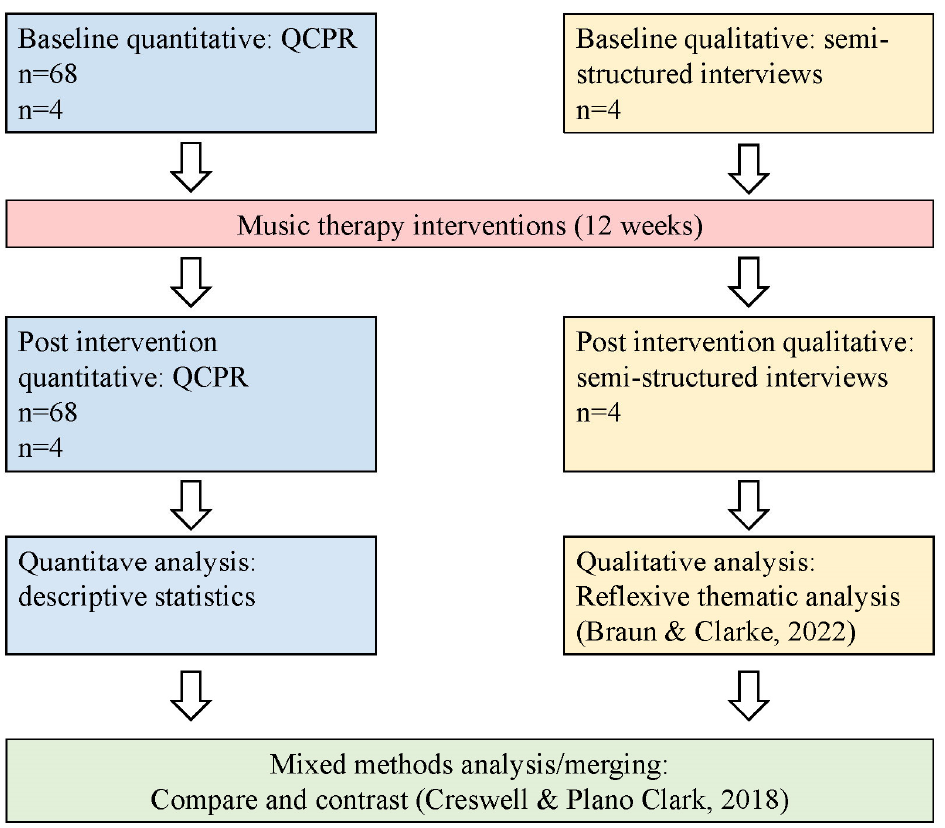
Figure 1. Data collection and analysis [33,41].